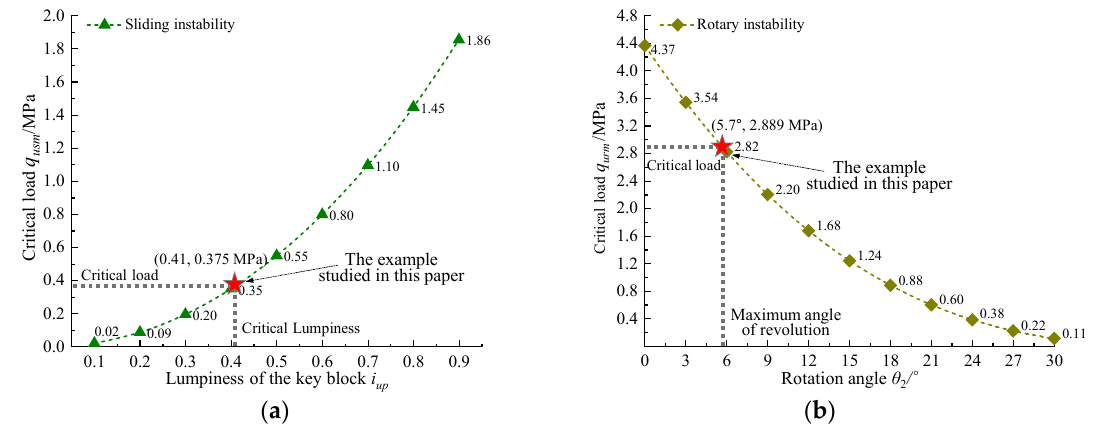
Figure 15. Stability analysis of the main roof of the upper coal seam. ( a ) Sliding instability of the upper main roof ( b ) Rotary instability of the upper main roof.